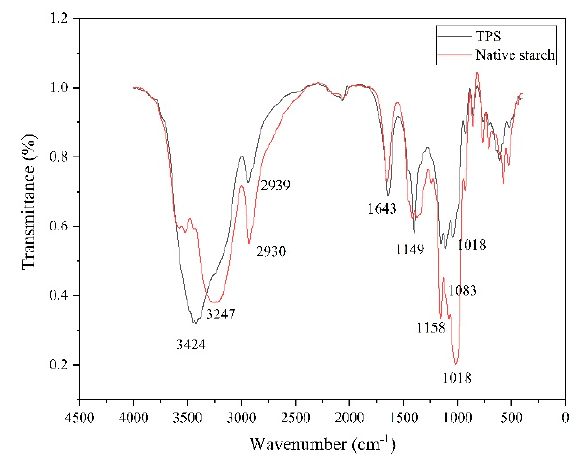
Figure 4. FTIR spectra of pristine cassava starch and plasticized starch.